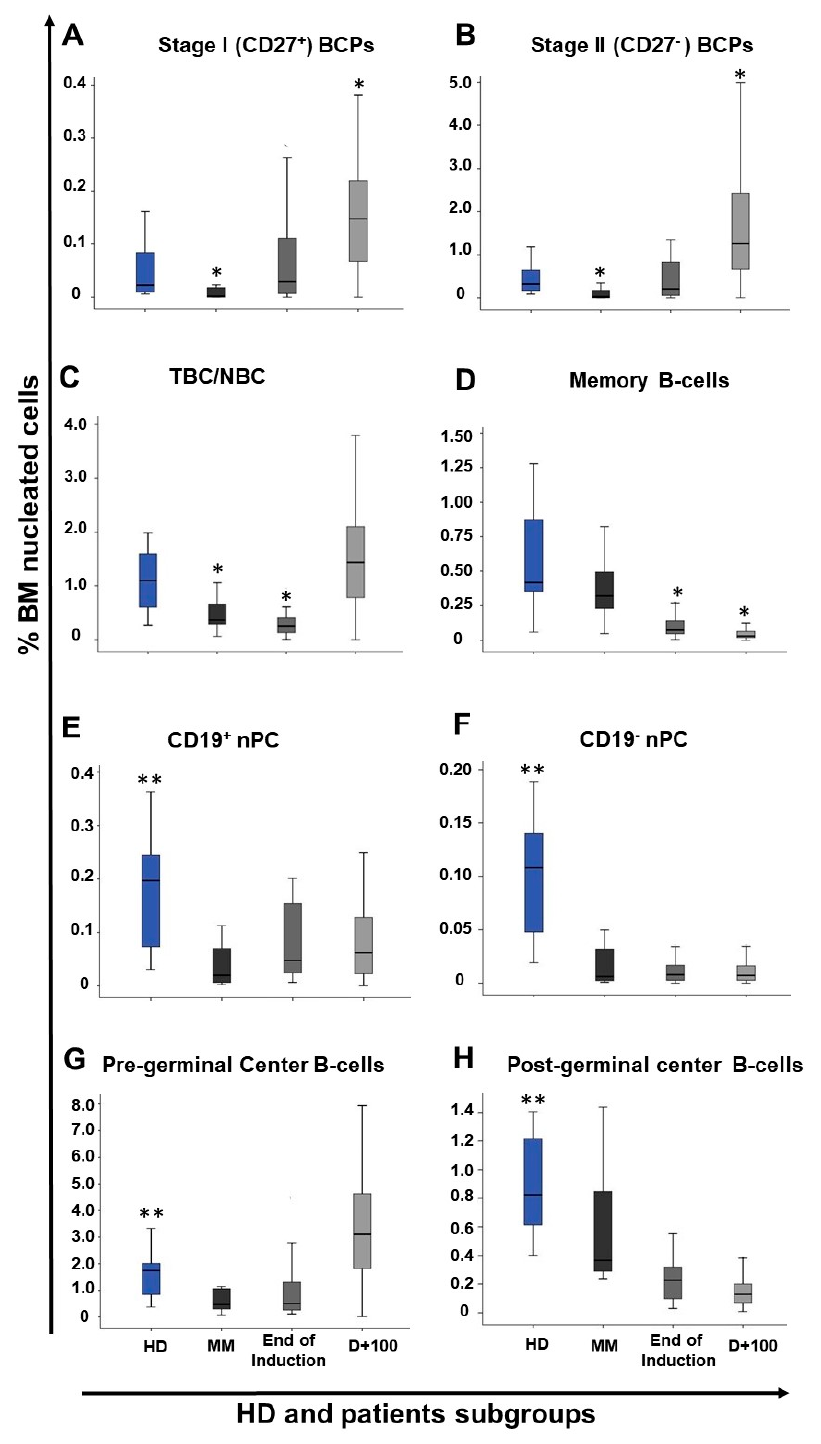
Figure 2. Distribution of normal/residual B-cell populations in BM samples from HDs (n = 14) vs. MM patients studied at diagnosis (n = 25) and subsequently at the end of induction therapy (n = 27) and at day+100 post autologous stem cell transplantation (ASCT) (n = 94). In panels A and B, the distributions of stage I (CD27 + ) and stage II (CD27 − ) B-cell precursors (BCP) are shown, while in panels C and D, the distributions of TBC/NBC and memory B-cells are displayed, respectively. In turn, panels E and F display the distribution in BM of CD19 + and CD19 − normal plasma cells, respectively, whereas in panels G and H the distributions of all pre-germinal center and post-germinal center B-cell populations in BM are shown, respectively. * p value < 0.05 vs. HD and ** p value <0.05 HD vs. all groups. BM, bone marrow; HD, healthy donor; BCP, B-cell precursors; TBC/NBC, transitional/naïve